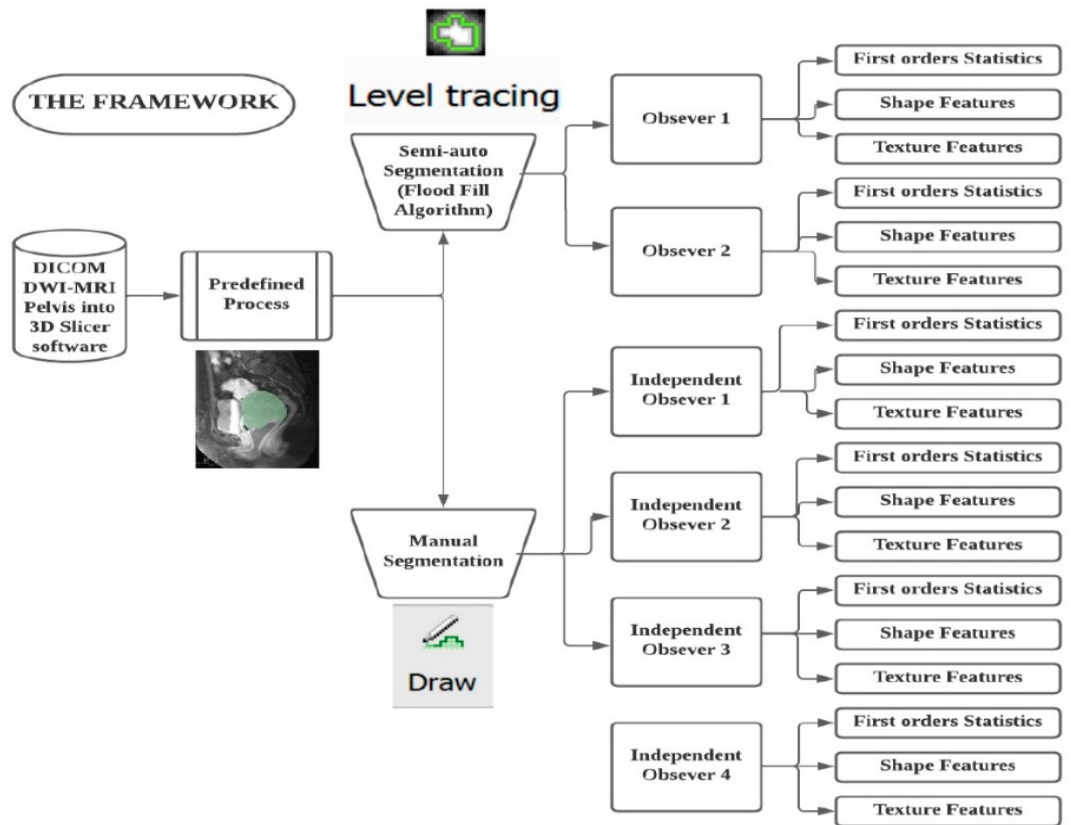
Figure 2. The research process in comparing different segmentation process.